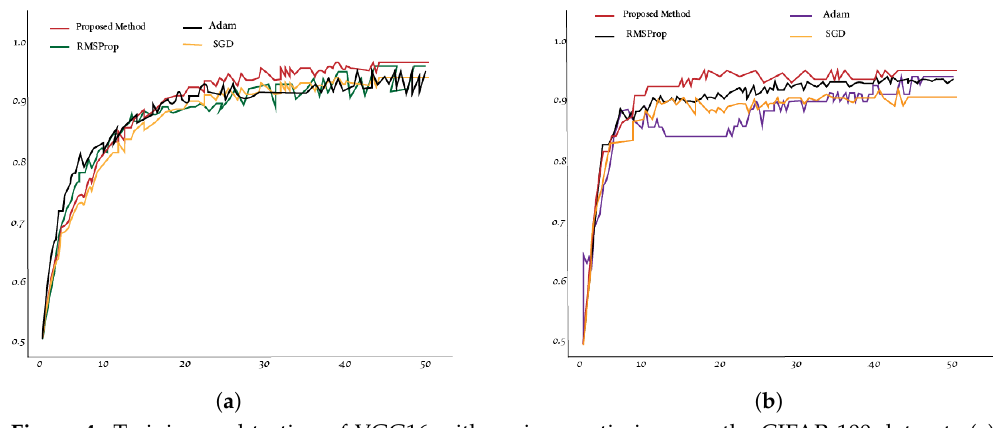
Figure 4. Training and testing of VGG16 with various optimizers on the CIFAR-100 dataset. ( a ) Training accuracy. ( b ) Testing accuracy.